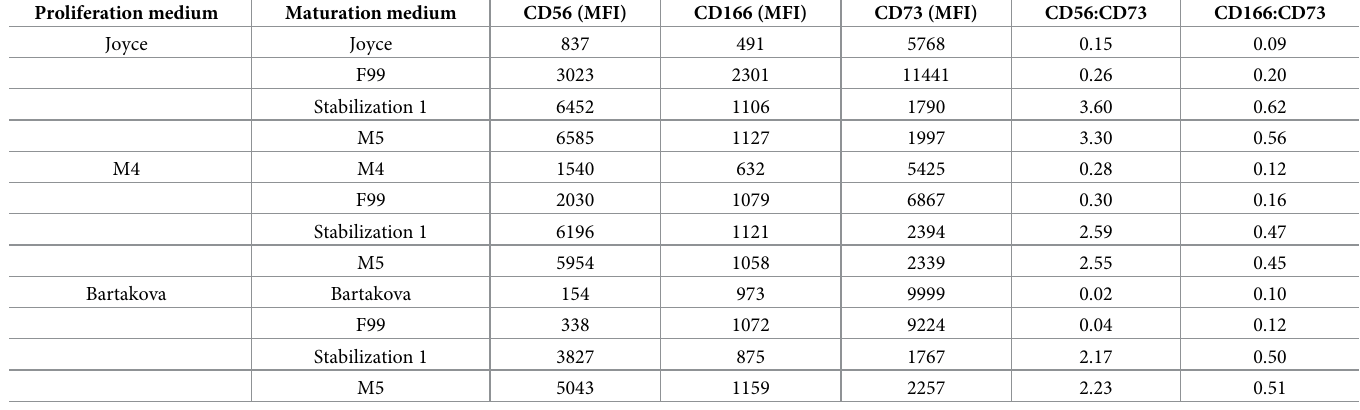
MFI; mean fluorescence